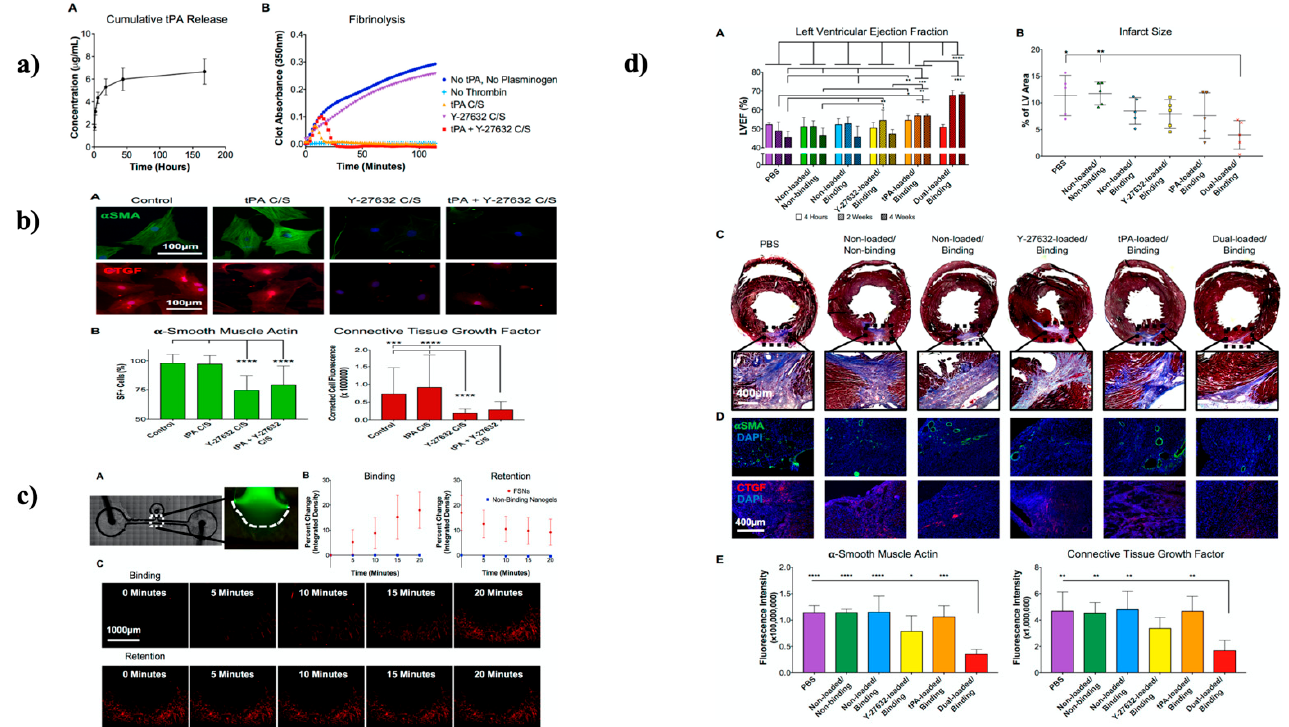
Figure 5. ( a ) Effective burst release of tPA is indicated by cumulative tPA release from C/S nanogels (A) and examination of fibrinolysis in the existence of drug-loaded nanogels (B). ( b ) The expression of fibrotic markers such as -SMA and CTGF on neonatal rat cardiac fibroblasts is reduced by introducing drug-loaded C/S particles in vitro (A). Percentage of stress fiber-positive cells for -SMA and adjusted total cell fluorescence for CTGF were used to quantify the results (B). ( c ) In vitro, FSNs adhere to and are maintained at fibrin clot borders at 1 sec-1 wall shear rates. A fibrin clot (green) was polymerized along the channel using PDMS molds (A). Particle binding (red) throughout 20 min and retention (C) during a 20 min buffer wash demonstrate deposition at fibrin clot sites, as measured by fluorescence intensity at the clot boundary (B). ( d ) In vivo dual-loaded FSNs augment left ventricular ejection fraction 2 and 4 weeks after I/R (A). Dual-loaded FSNs dramatically reduce infarct size (B) 4 weeks after damage, as measured by Masson’s trichrome staining and measuring blue collagen stain as a percent of the left ventricular area (C). Four weeks after I/R (D), dual-loaded FSNs significantly reduce -SMA (top, green) and CTGF (bottom, red) expression in vivo, as measured by immunofluorescence intensity (E). (*), (**), (***), and (****) represented p < 0.05, p < 0.01, p < 0.001, and p < 0.0001, respectively . Reproduced with permission from [249], copyright ACS, 2018.